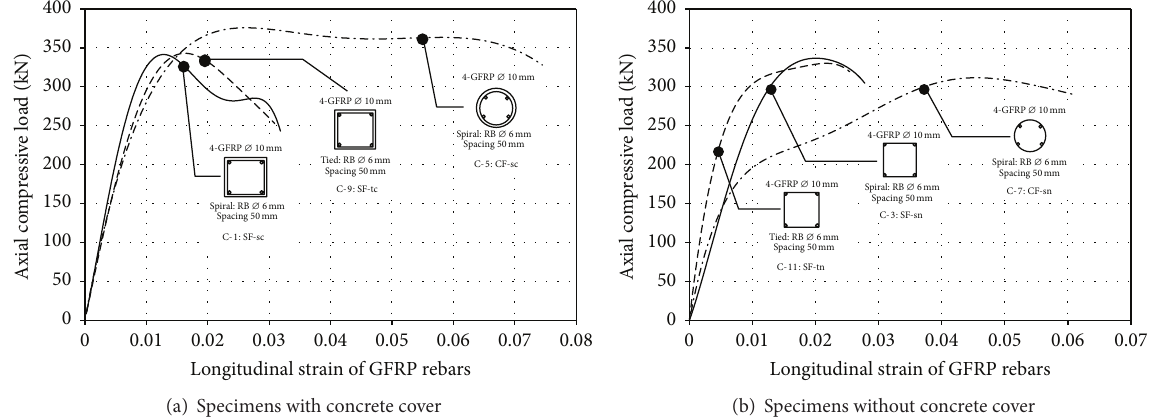
Figure 7: Load-strain curves of GFRP rebars.